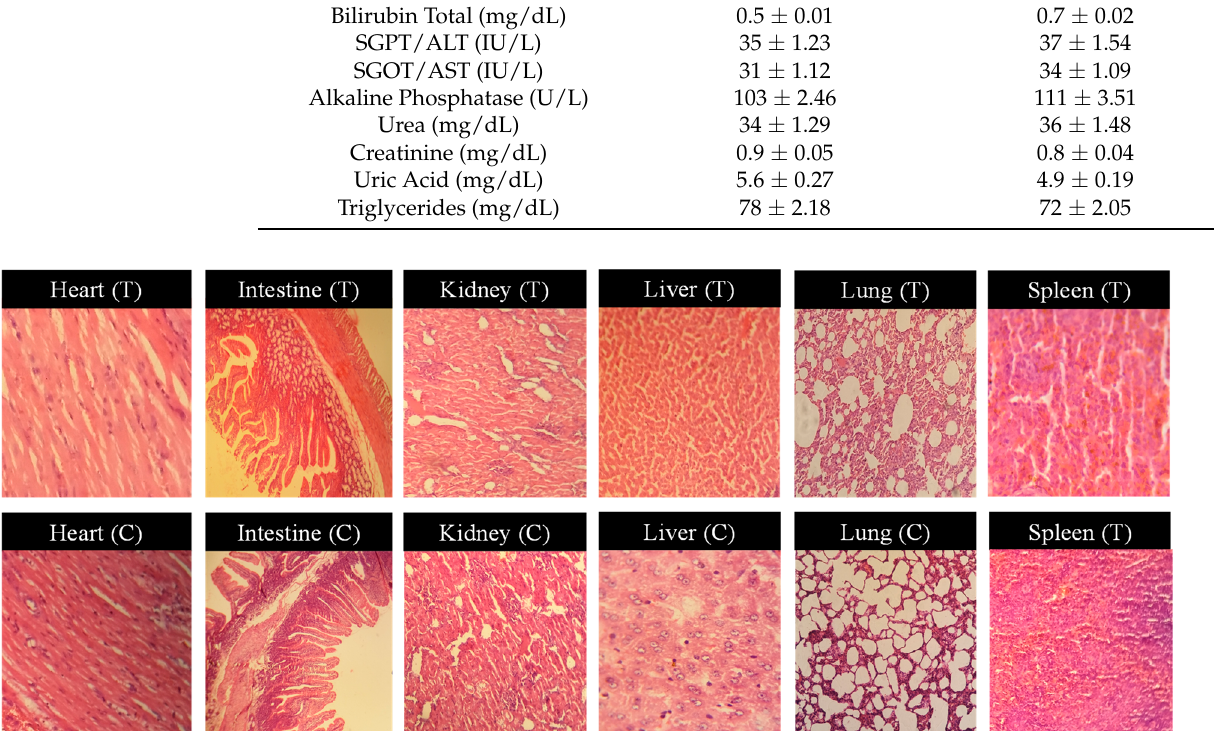
Figure 10. Histological slide representations of vital organs of experimental rabbits, control group (C) and Ins-Mmt-BA hydrogel NC-treated group (T) at 100×. (Analysis date 18 July